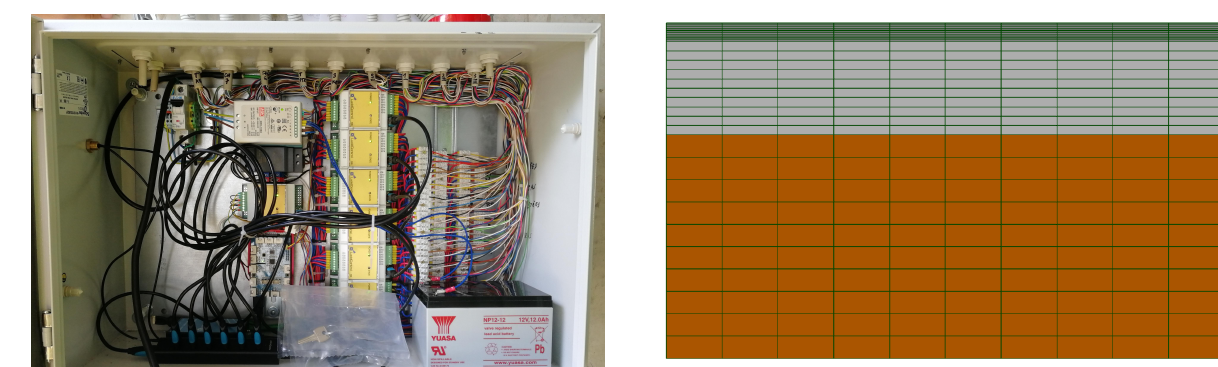
Figure 5. Mesh for abutment shaft model with visible